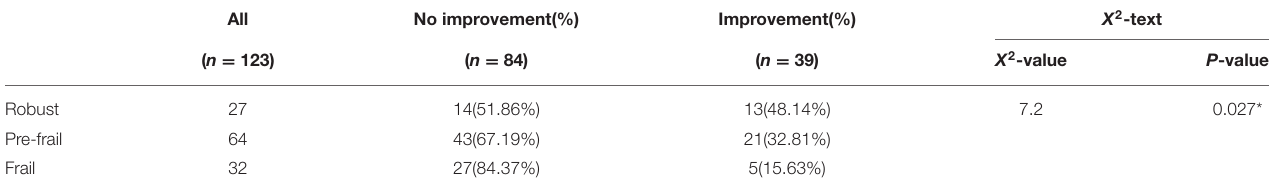
TABLE 8 | Functional improvement after 1 year follow-up for functional recovery analysis. All No